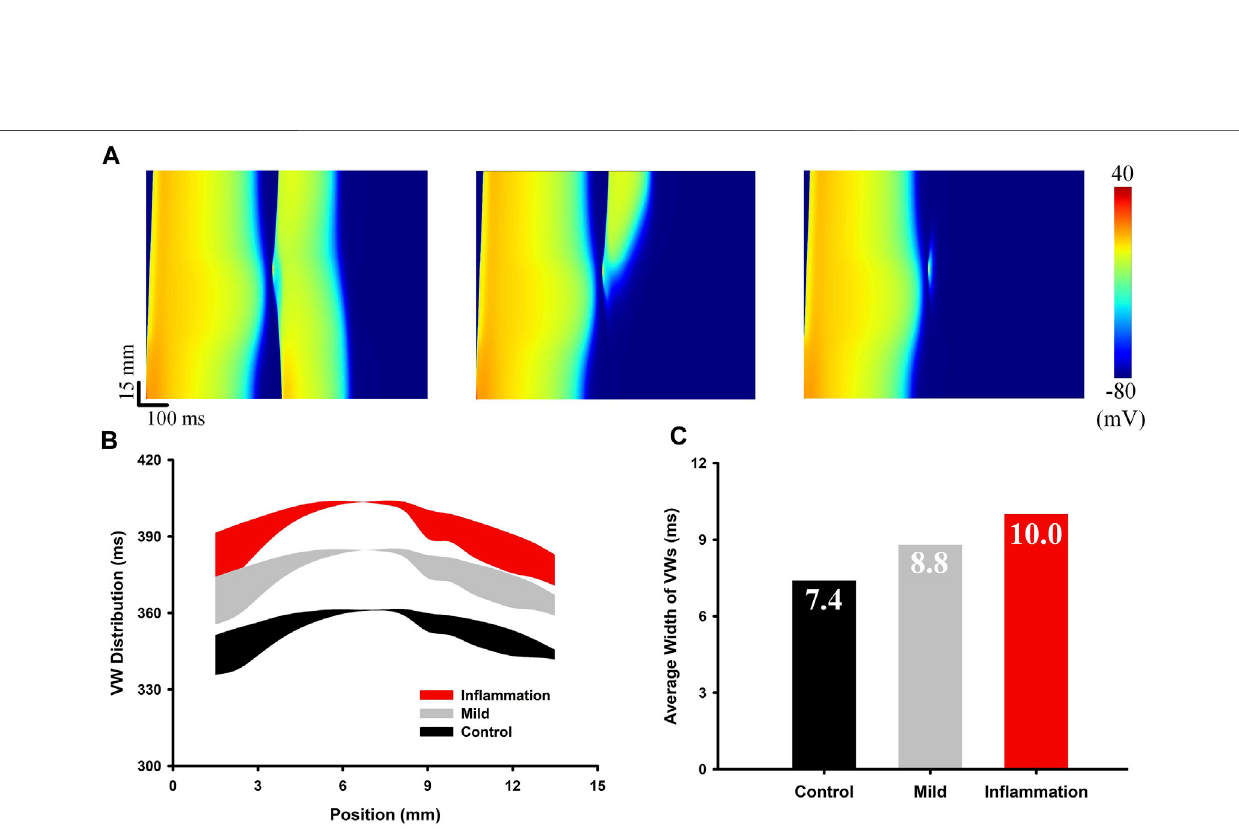
Frontiers in Physiology |